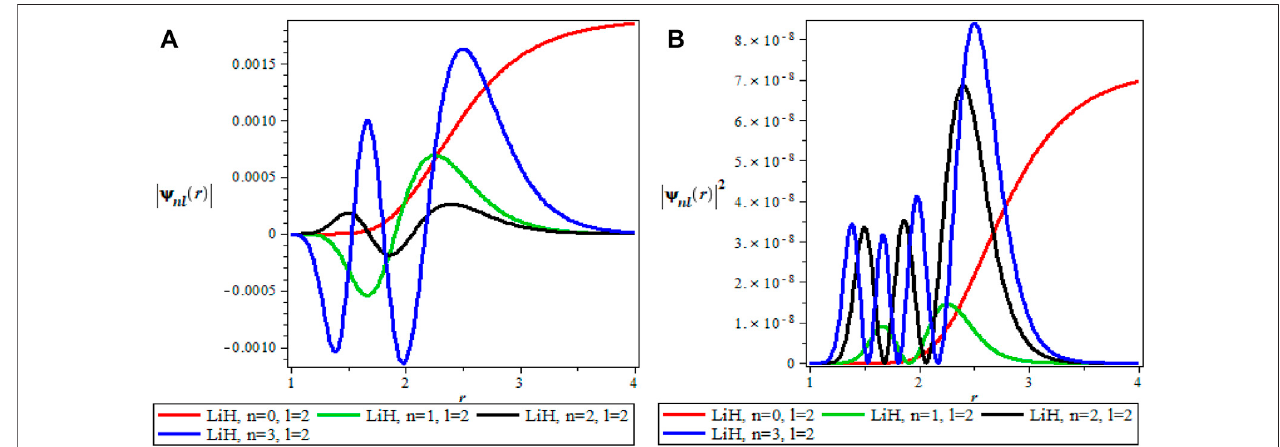
FIGURE 3 | (A) Wavefunction plot for fi xed l = 2 for LiH molecule. (B) Probabilty density plot for fi xed l = 2 for LiH molecule.